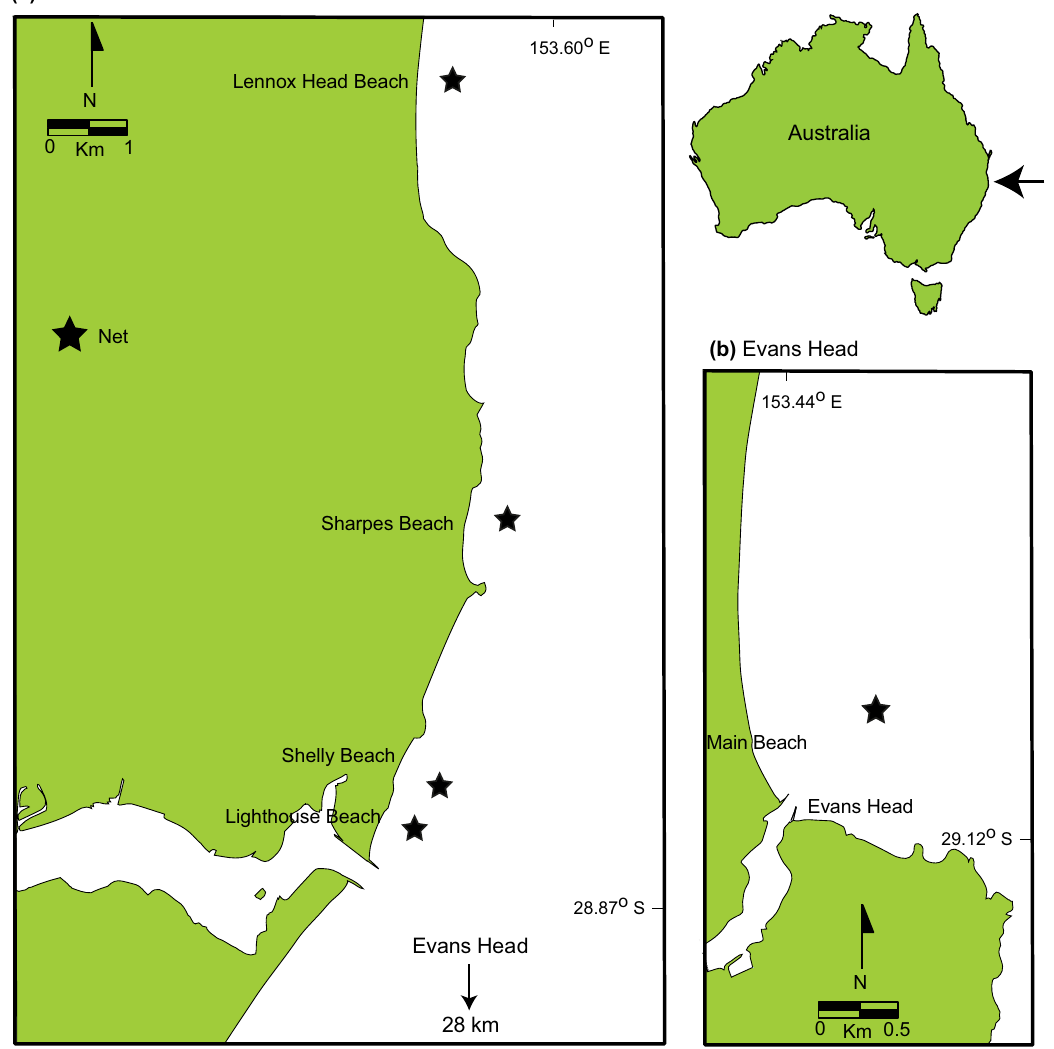
Figure 1. Location of bather-protection gillnets deployed off ( a ) Ballina and ( b ) Evans Head in NSW, Australia from which sharks were sampled between 7 February and 13 March, 2018. Maps were taken and modified from www. outli ne- world map.